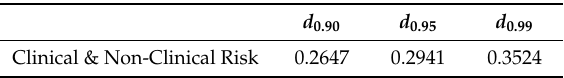
Table 3. Critical value test of frequency distribution.